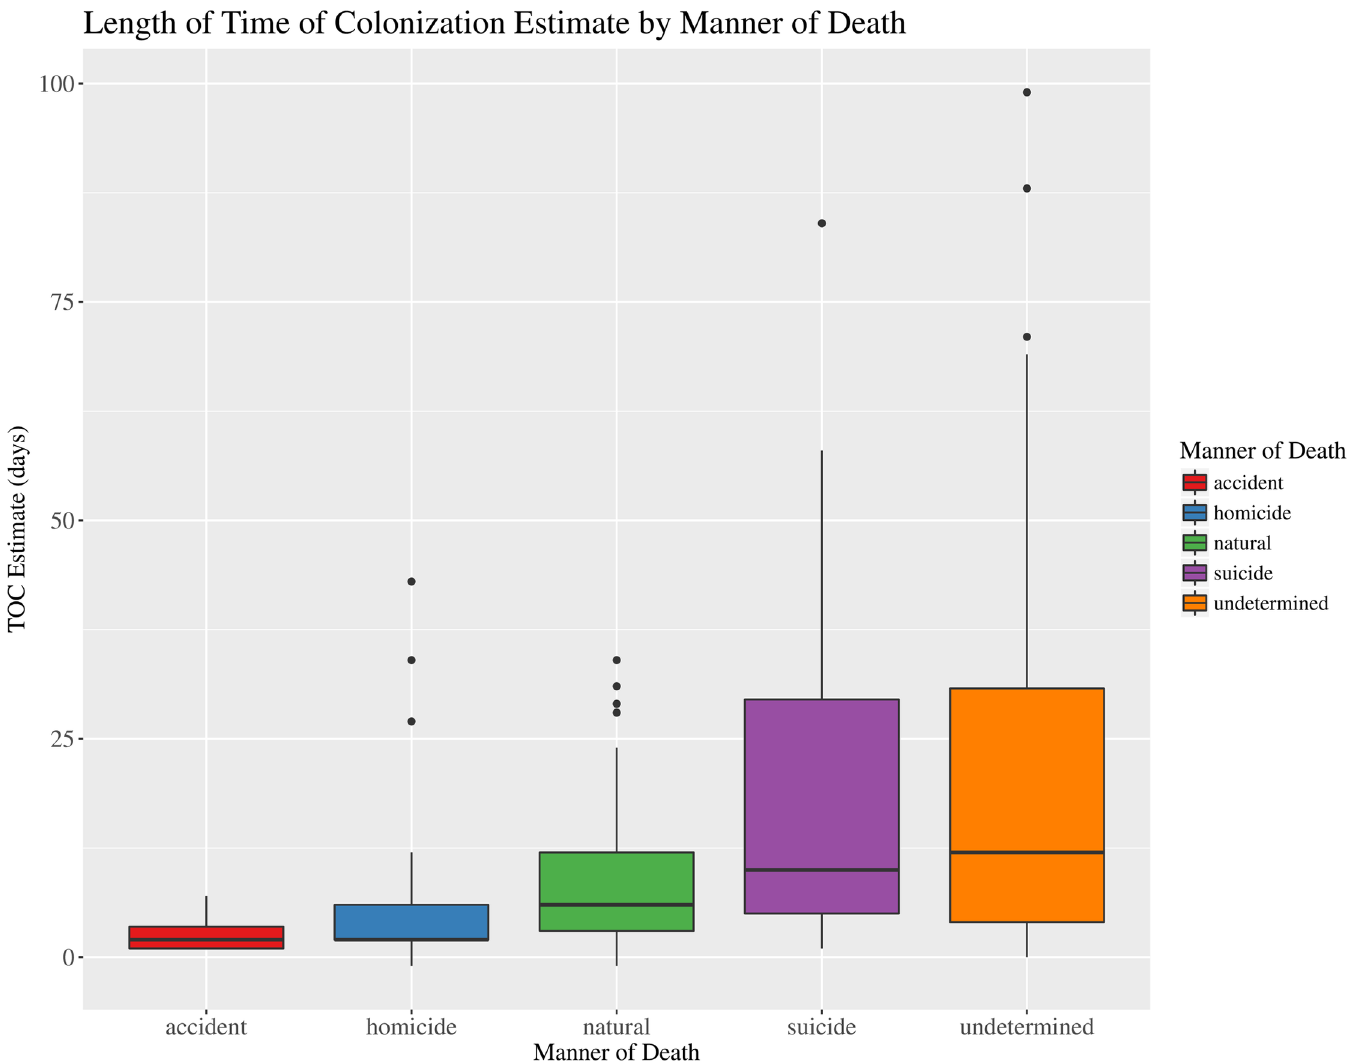
Fig 5. Boxplot of median time of colonization (TOC) estimate(days) by manner of death. Boxplot illustratingthe mediantime of colonization (TOC) estimate (days) and associated variationfor decedents by the Manner of death classification for forensic entomology cases over the study period(January 2013–April 2016). (N =